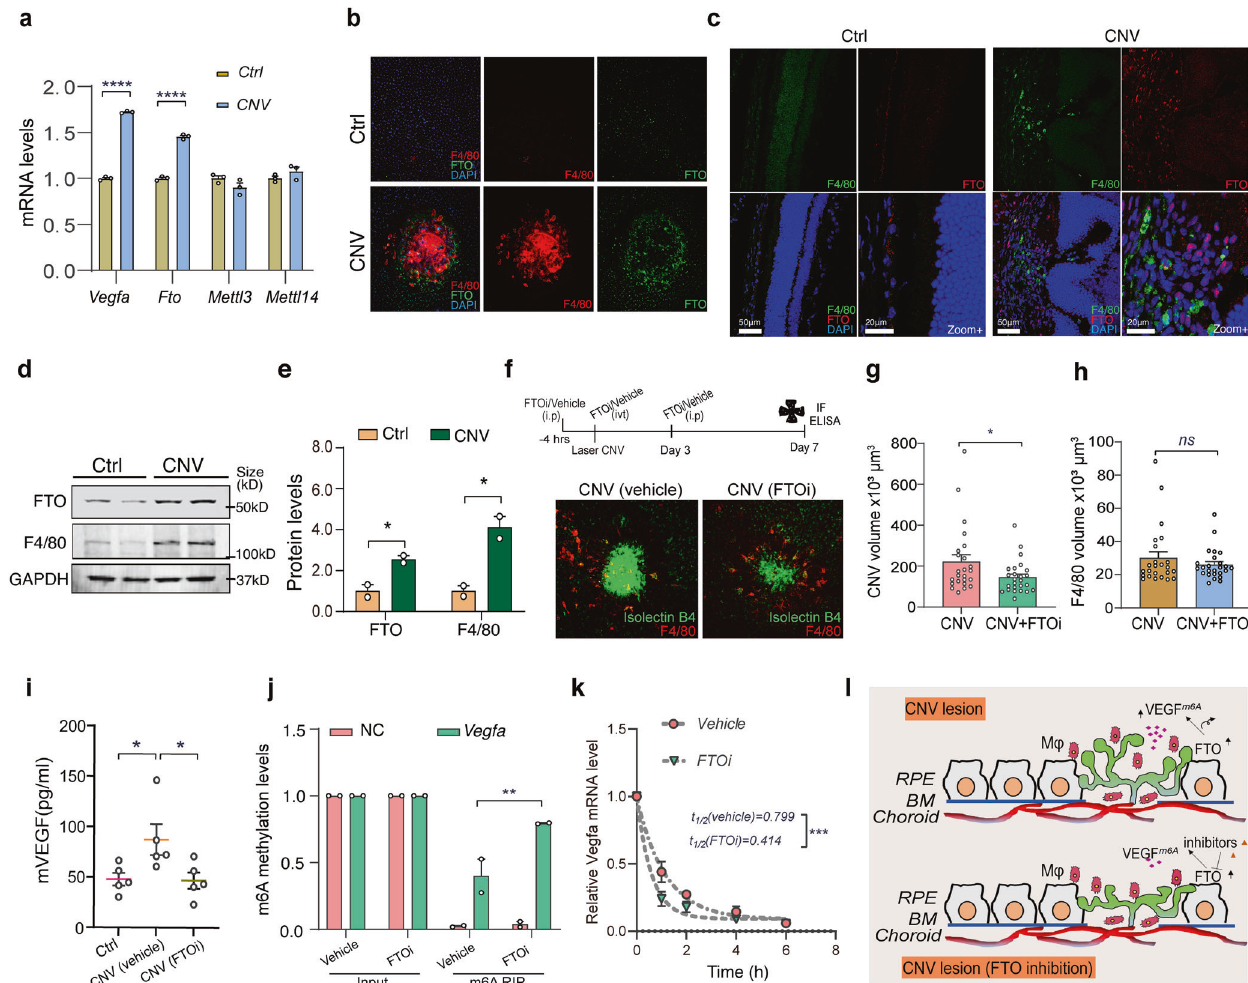
Fig. 1 FTO in macrophage VEGFA release and choroidal neovascularization. a Quanti fi cation of Vegfa , m6A methyltransferase ( Mettl3, Mettl4 ), demethylase ( Fto ) mRNA levels in pooled eye tissues ( n = 3) of control, naive (no laser treated) mice (Ctrl) or mice following laser injury (choroidal neovascularization, CNV, day 3 after laser injury). b , c Immuno fl uorescent staining of FTO in fl at-mounted RPE-choroid tissues ( b ) and cryosections of eyes ( c ) at 3 days after laser injury. F4/80 immunostaining indicates macrophage in fi ltration following laser injury. d , e Immunoblotting and quanti fi cation of FTO and F4/80 protein levels in RPE-choroid tissues isolated from mice eyes at 3 days after laser injury ( n = 2 eyes). f Immuno fl uorescent staining of neovascularization using isolectin B4 (green) and of macrophages by F4/80 (red) in RPE- choroid tissues of mice treated with FTO inhibitor (FTOi) or vehicle, at 7 days after laser injury. g , h Quanti fi cation of CNV and F4/80 volumes based on isolectin B4 and F4/80 staining in RPE-choroid tissues of mice treated with FTO inhibitor (FTOi) or vehicle, at 7 days after laser injury ( n = 24 laser spots for Ctrl, and n = 25 spots for FTOi). i Quanti fi cation of VEGFA levels in the RPE/choroid tissues of mice treated with FTO inhibitor (FTOi) or vehicle, at 3 days after laser injury ( n = 5 eyes). j Quanti fi cation of methylated Vegfa mRNA levels in mouse BMDMs treated with FTO inhibitor (FTOi) or vehicle for 24 h by using MeRIP-qPCR ( n = 2). k Determination of Vegfa mRNA stability in BMDMs pretreated with FTO inhibitor (FTOi) or vehicle, followed with Actinomycin D inhibition (10 µg/ml). mRNA abundance was measured by RT-qPCR at the indicated time points and Vegfa mRNA half-lives ( t 1/2 ) determined by fi tting the data to a nonlinear one phase decay model (mean ± SEM, n = 3). l Schematic diagram showing FTO regulates VEGFA release and choroidal neovascularization in AMD. Retinal pigment epithelium RPE, BM Bruch ’ s membrane, M φ macrophages. Data are shown as mean ± SEM, * p < 0.05; ** p < 0.01; *** p < 0.001; **** p < 0.0001; ns not signi fi cant. Two-way ANOVA with Sidak ’ s multiple comparisons ( a , c ); One-way analysis of variance (ANOVA) with Dunnett ’ s multiple comparisons ( g ); unpaired two-tailed t -test ( e , j , g , k